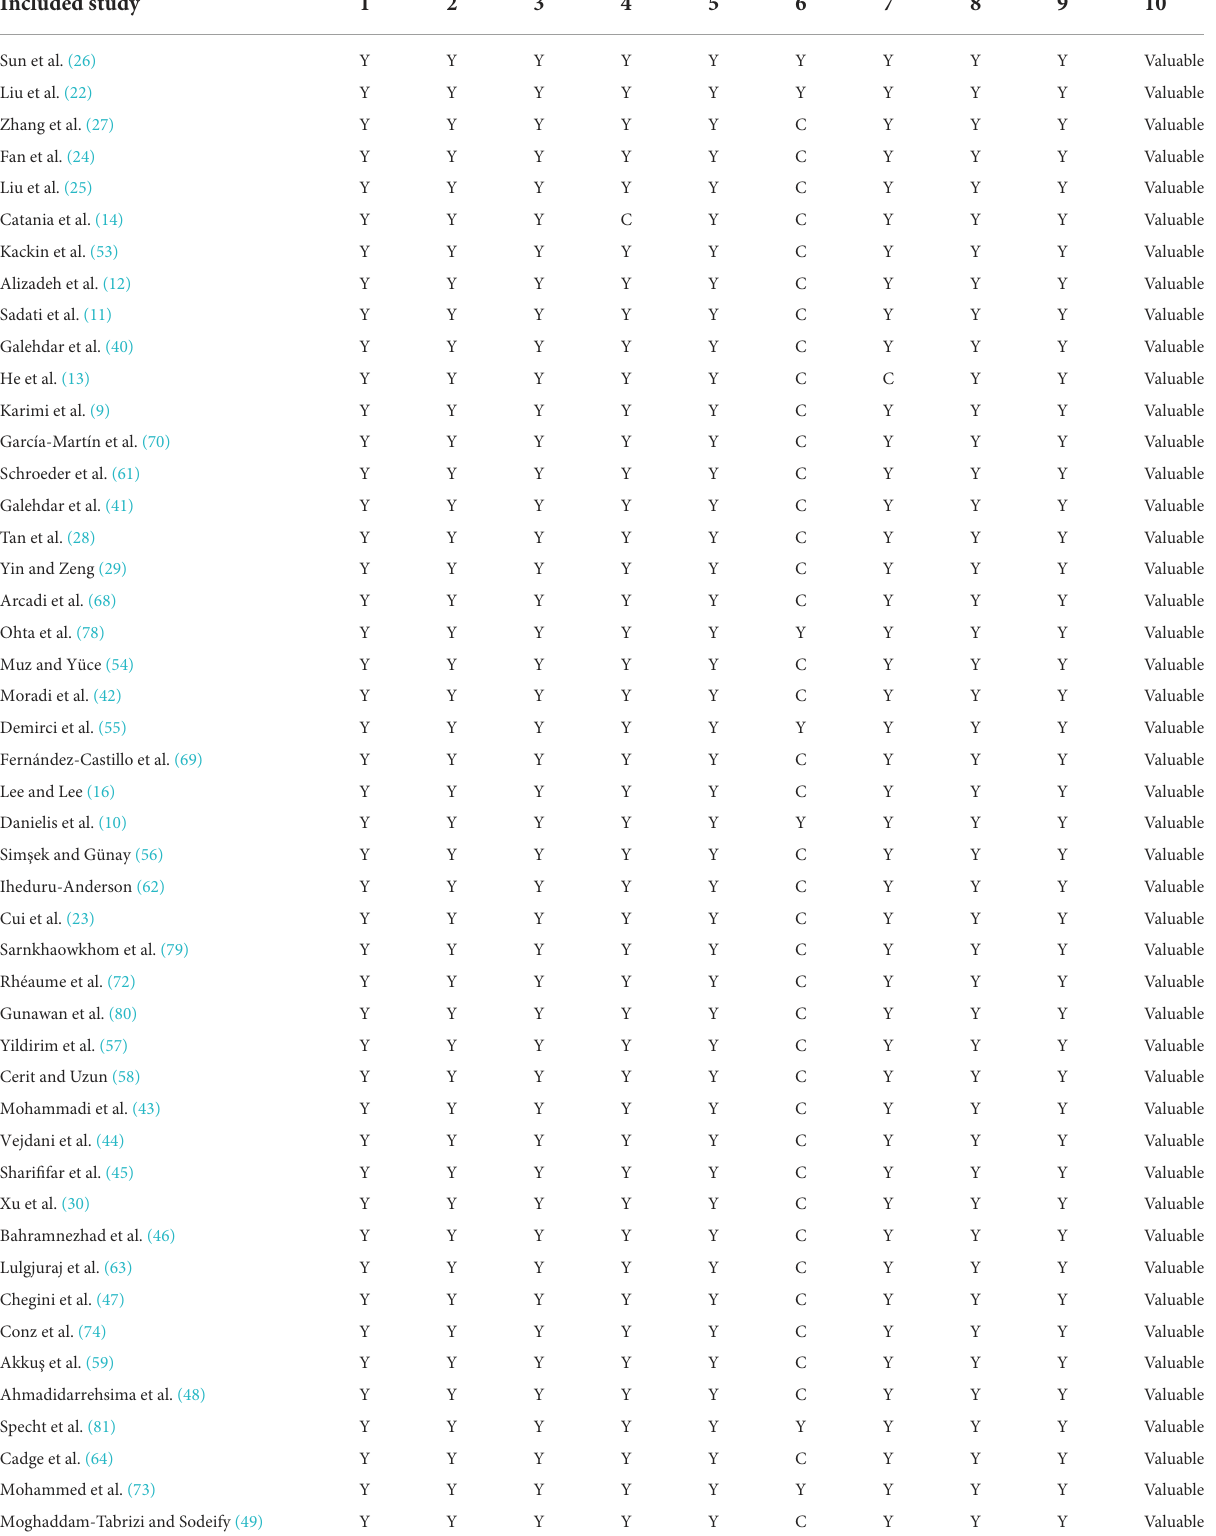
TABLE 3 Quality assessment of included